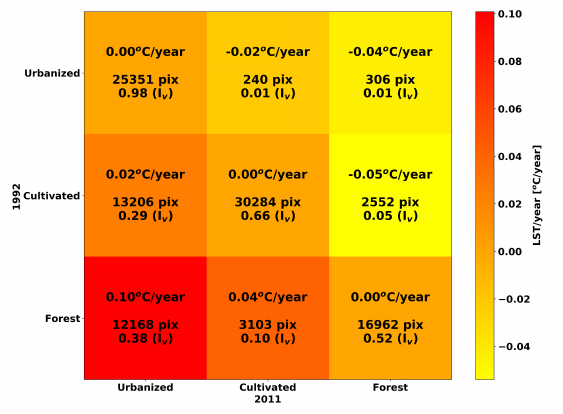
Figure 17. Houston MA: Detrended Rate